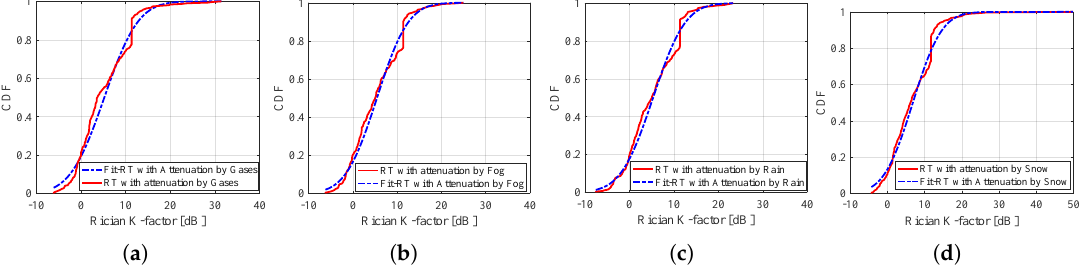
Figure 9. Rician K-factor, ( a ) by Gases; ( b ) by Fog; ( c ) by Rain; ( d ) by Snow.